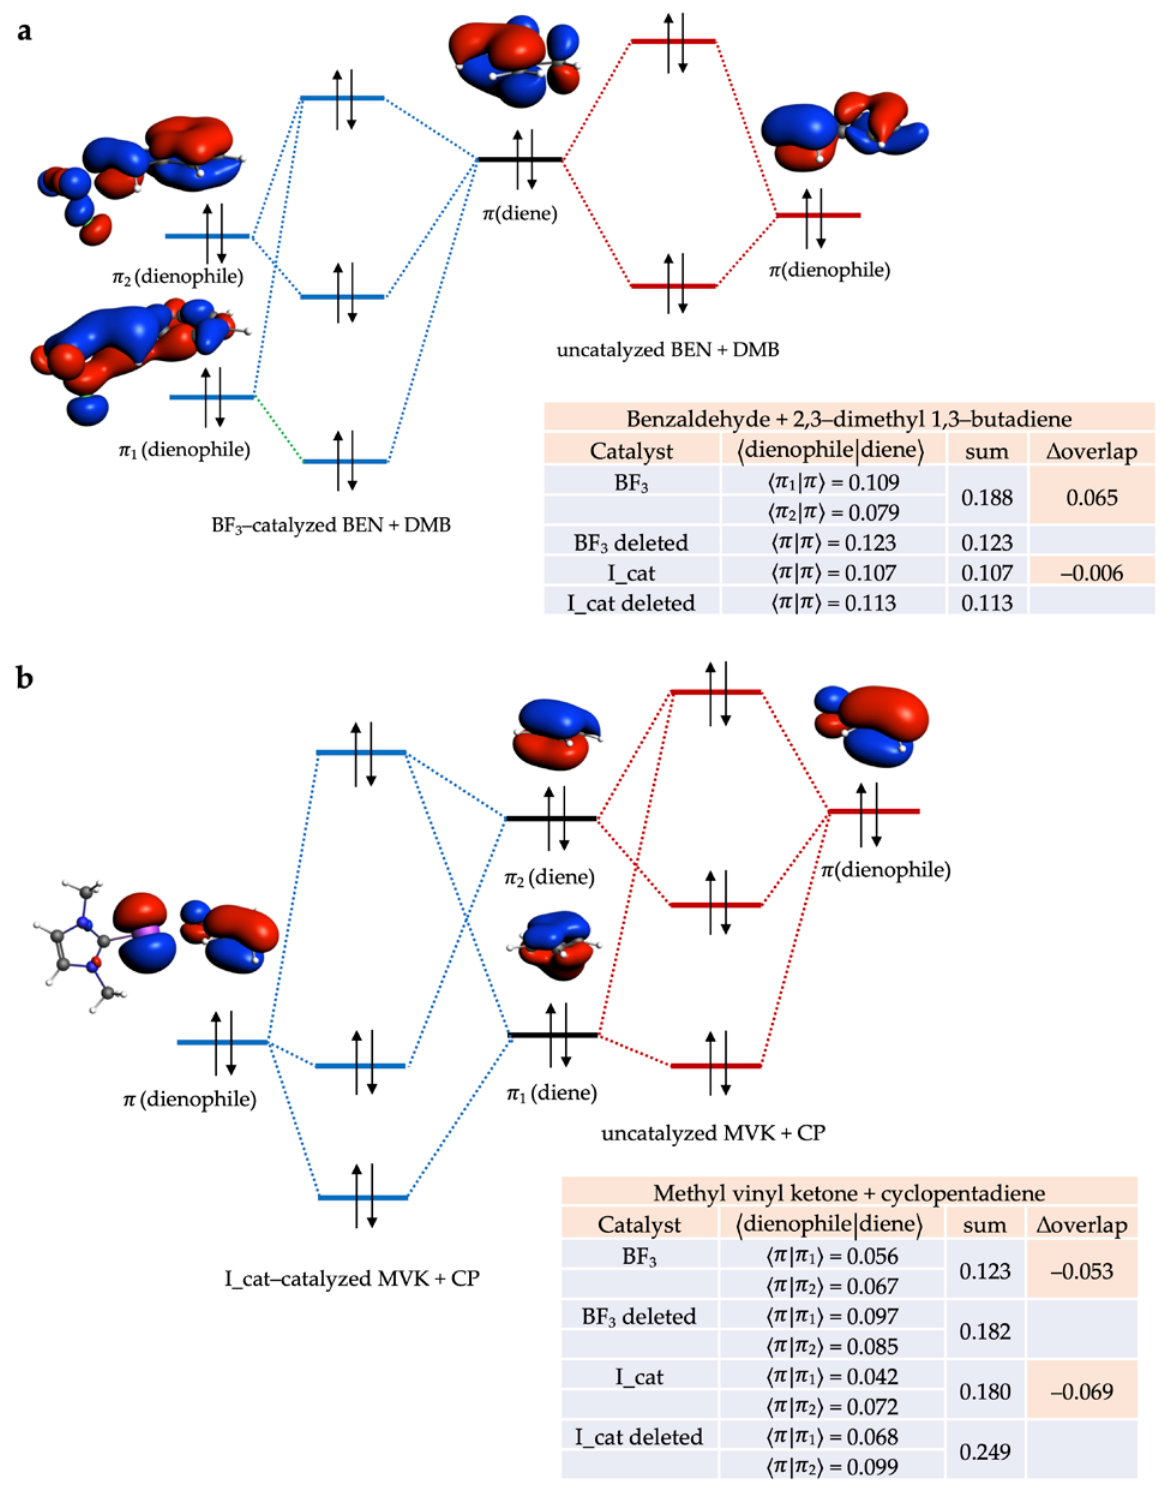
Figure 9. Molecular orbital diagrams showing the occupied π -MOs of diene and dienophile responsible for the main part of the Pauli repulsion energy term, and their occupied-occupied MO overlap values. ( a ) Catalyzed and catalyst-deleted benzaldehyde + 2,3-dimethyl 1,3-butadiene Diels–Alder reaction; ( b ) catalyzed and catalyst-deleted methyl vinyl ketone + cyclopentadiene Diels–Alder reaction. For the I_cat-catalyzed BEN + DMB reaction, no additional π -MO for I_cat-catalyzed BEN can be found. When we compare the overlap between the π -MO